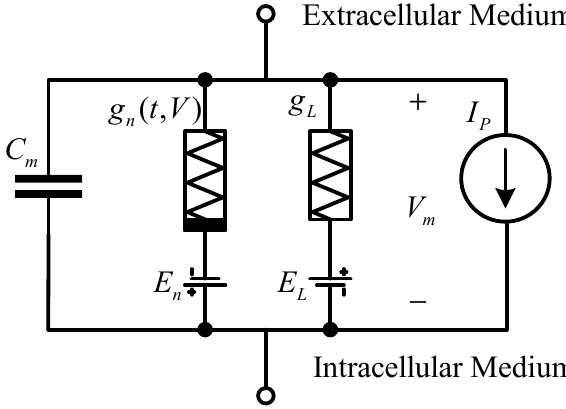
Figure 1. The Hodgkin–Huxley model.